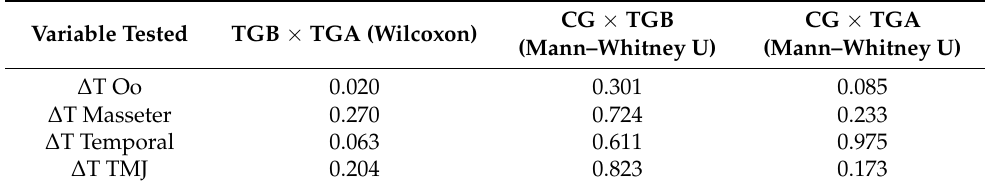
Table 2. Statistical data analysis of the intra- and inter-group comparisons of the ∆ T values of each ROI.